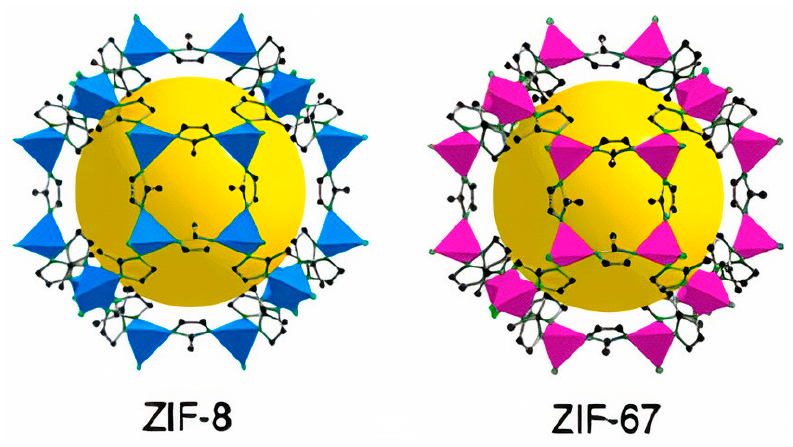
Figure 2. ZIF-8 and ZIF-67 structure, reproduced with permission from [58]. Copyright Elsevier, 2021.